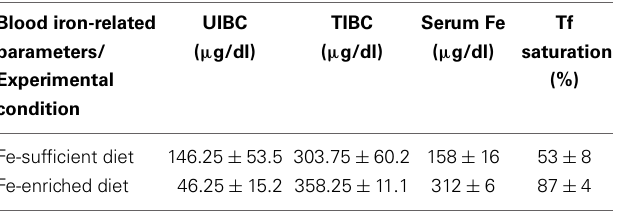
Table 1 | Serum iron-related parameters in mice fed iron-sufficient and iron-enriched